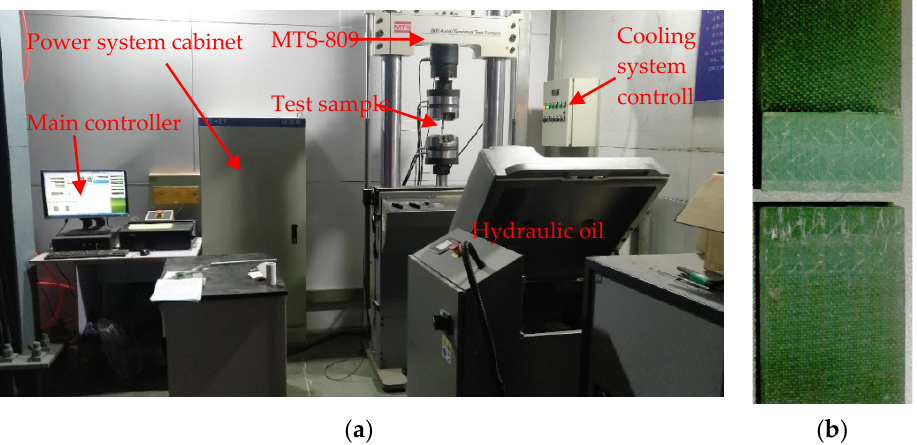
Figure 6. Laboratory and fracture morphology of the specimen: ( a ) Equipment and environment of the laboratory; ( b ) Fracture morphology of one specimen.